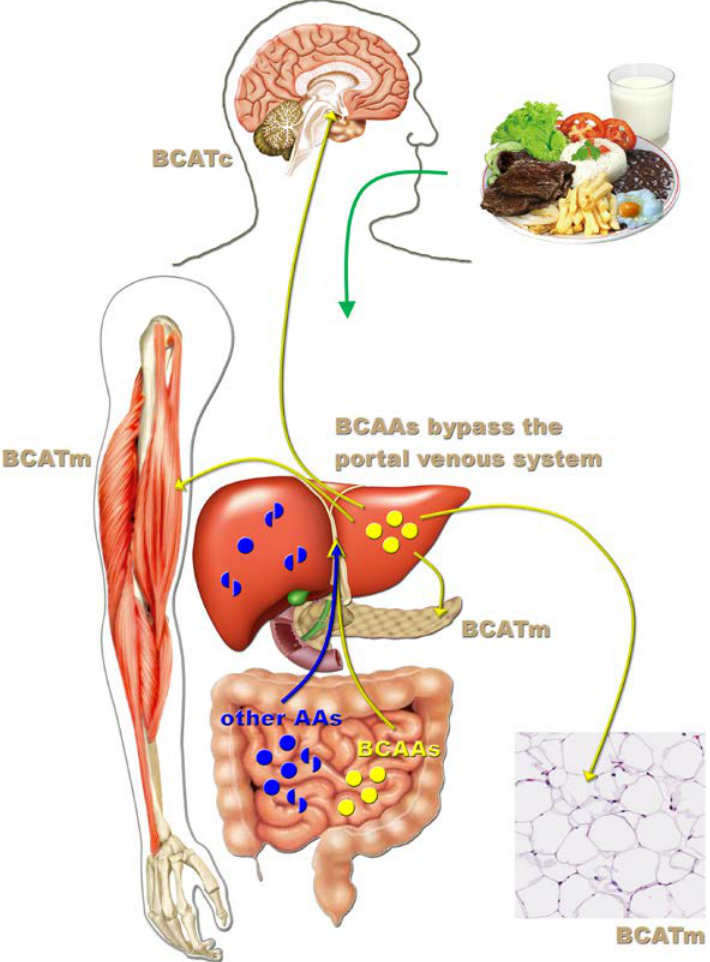
Figure 2. Leucine-responsive tissues. After protein-rich meals, circulating BCAA levels significantly increase, whereas other amino acids are highly metabolized by the gut or liver before reaching the systemic circulation. Branched-chain amino acid transaminase (BCAT) catalyzes the first and reversible transamination step of leucine degradation. This enzyme is not expressed in the liver, which allows the BCAAs to bypass the portal venous system following their intestinal absorption. In the brain, leucine is metabolized by the cytosolic form of BCAT (BCATc), whereas in other tissues (e.g., white adipose tissue, skeletal muscle, and pancreas), the mitochondrial form of BCAT (BCATm)